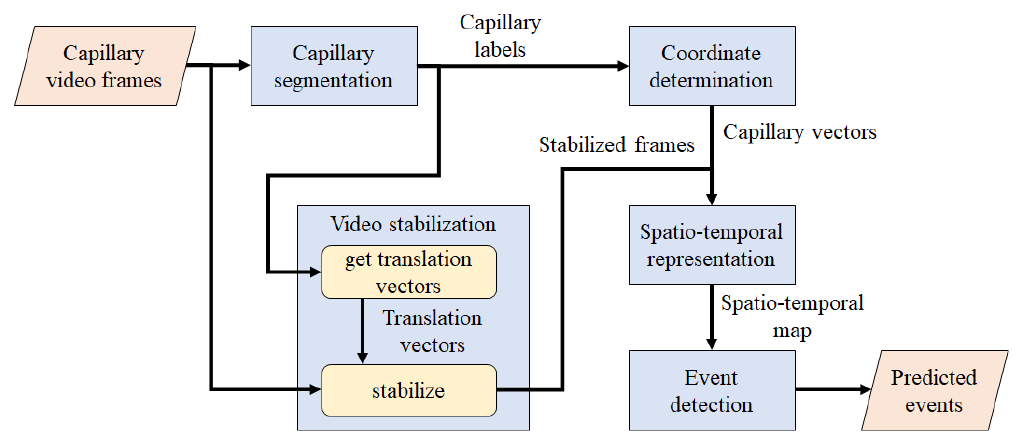
Figure 2. Overview of the proposed WBC counting process.